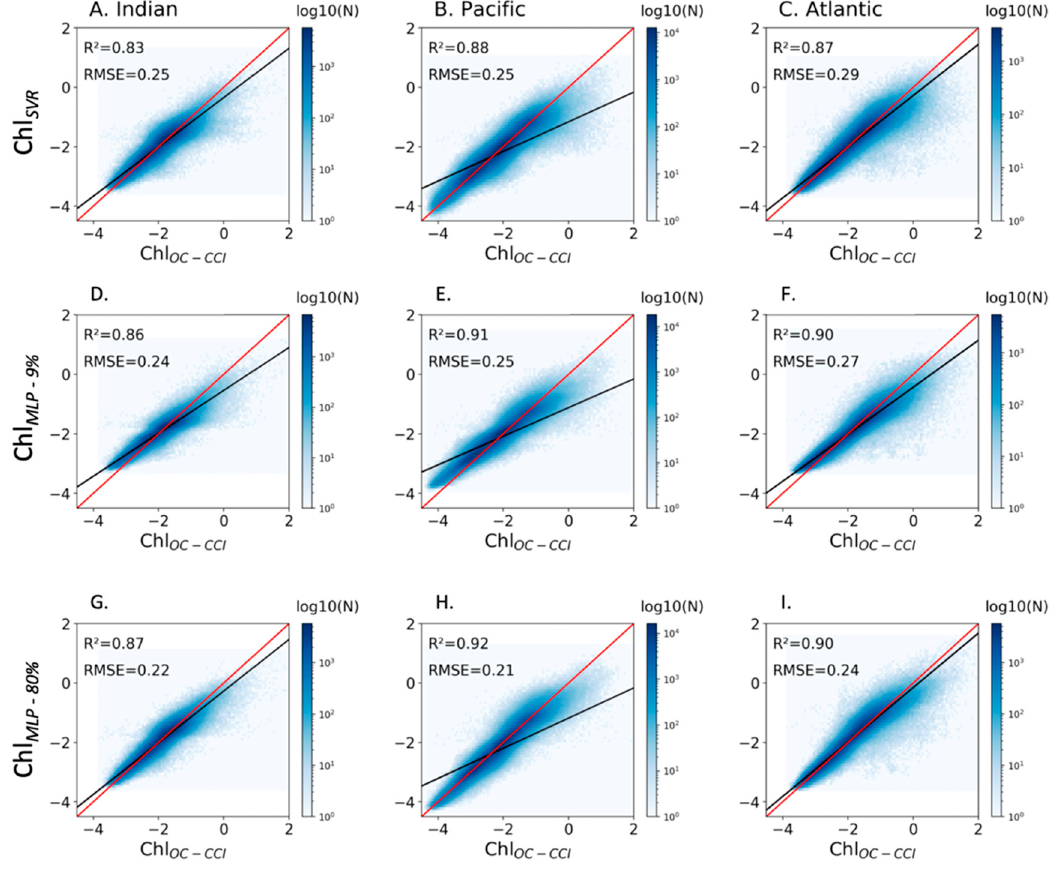
Figure 2. Scatter plots of log of Chl OC-CCI vs. ( A – C ) Chl SVR , ( D – F ) Chl MLP-9% and ( G – I ) Chl MLP trained on 80% of the dataset, for each oceanic basin between 50° S and 50° N and over 1998–2015. The Chl OC-CCI vs. reconstructed Chl regression lines are plotted in black and the 1:1 regression lines are plotted in red. The figure is color-coded according to the density of observations.